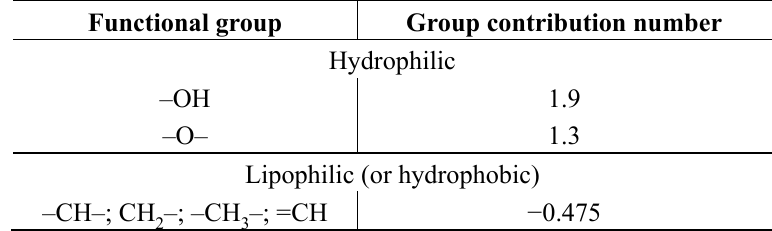
Table 2. The selected group number used in the Davies method of estimating hydrophile-lipophile balance